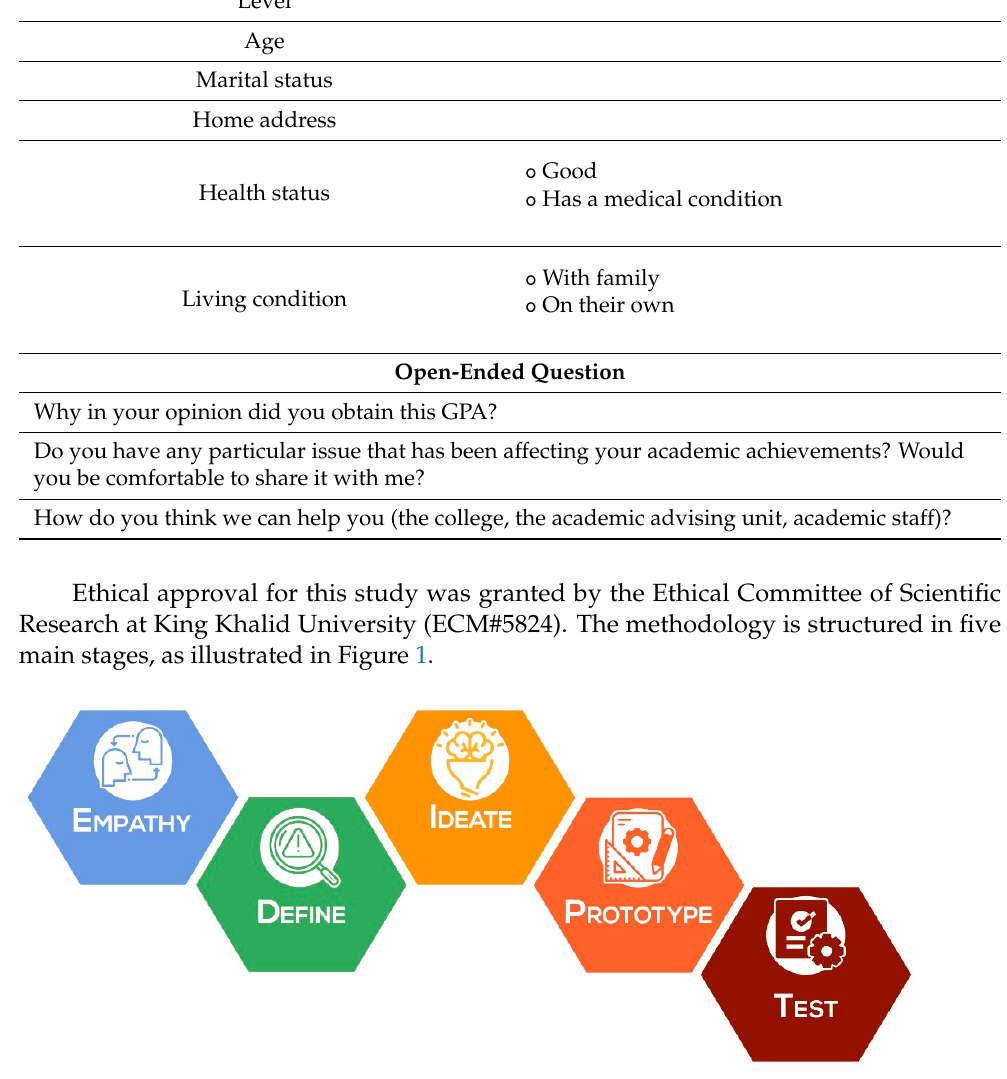
Figure 1. Stages of the design thinking